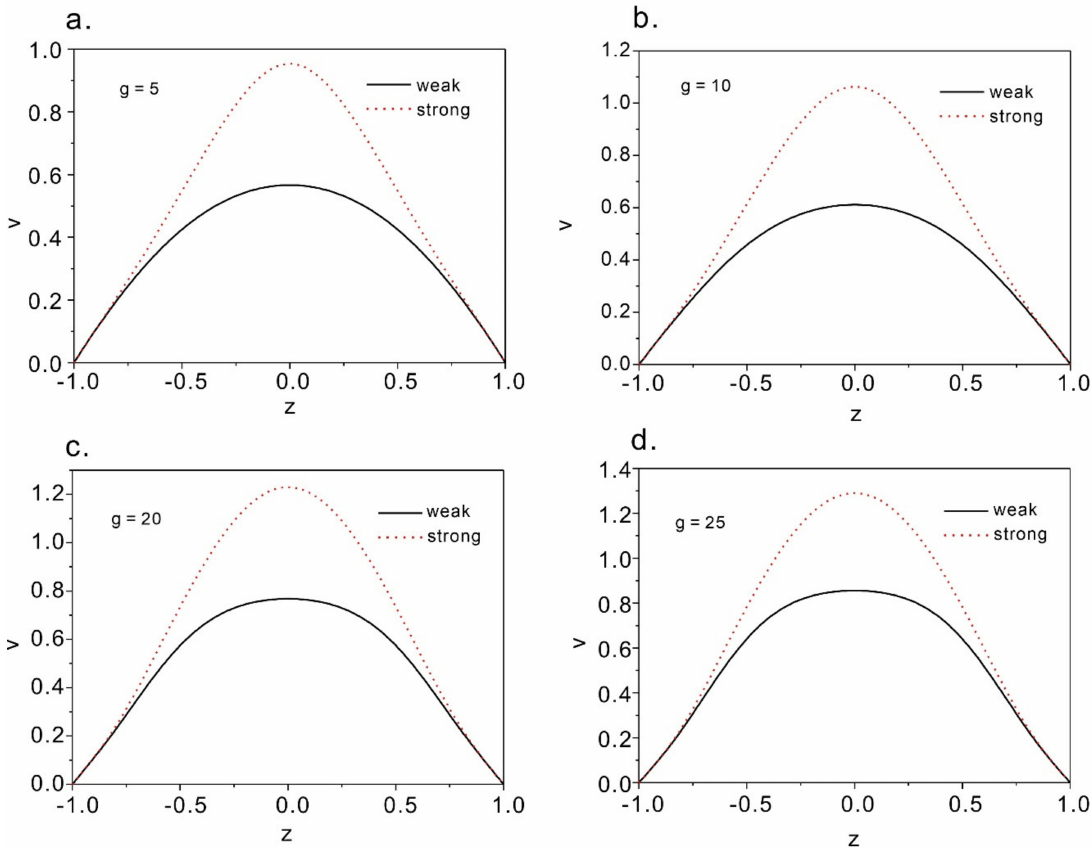
Figure 5. Strong and weak flow solutions at different dimensional pressure gradients. ( a – d ) correspond to the condition of g = 5, 10, 20, and 25